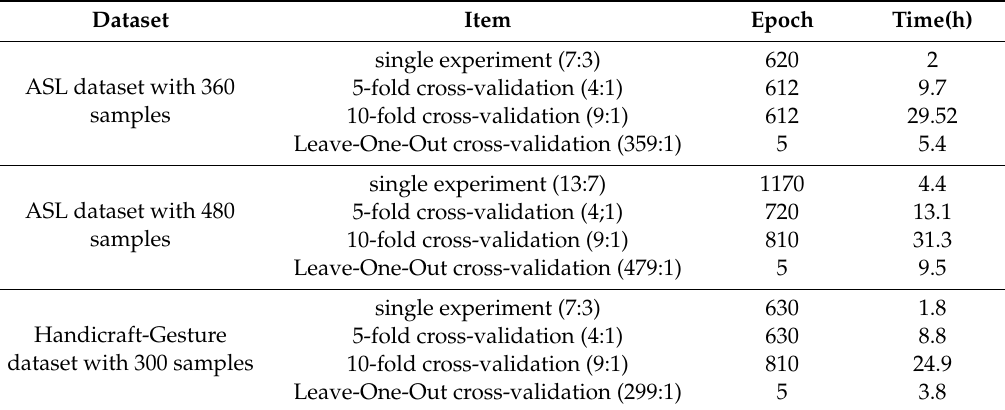
Table 8. The computation time of the